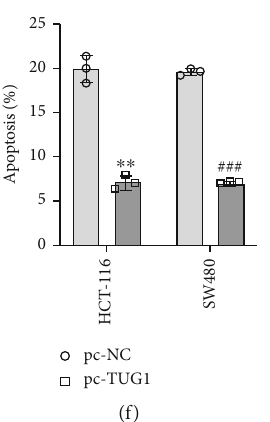
Figure 2: E ff ect of lncRNA TUG1 on oxaliplatin resistance of CRC stem cells. (a) lncRNA TUG1 was silenced in the CD133 + /CD44 + cells isolated from HCT-116 and SW480 cells, and then, the cells were treated with 0, 1, 2, 4, 8, and 16 μ M oxaliplatin for 48 h. Cell Counting Kit- 8 (CCK-8) assay was performed to assess the viability of CD133 + /CD44 + isolated from HCT-116 and SW480 cells. (b) lncRNA TUG1 was silenced in the CD133 + /CD44 + cells isolated from HCT-116 and SW480 cells, and then, the cells were treated with 4 μ M oxaliplatin for 48 h. The apoptosis of CD133 + /CD44 + isolated from HCT-116 and SW480 cells was detected using fl ow cytometry. (c) The quantitative results of cell apoptosis. (d) lncRNA TUG1 was overexpressed in the CD133 + /CD44 + cells isolated from HCT-116 and SW480 cells, and then, the cells were treated with 0, 1, 2, 4, 8, and 16 μ M oxaliplatin for 48 h. Analysis of the viability of CD133 + /CD44 + isolated from HCT-116 and SW480 cells by CCK-8 assay. (e) lncRNA TUG1 was overexpressed in the CD133 + /CD44 + cells isolated from HCT-116 and SW480 cells, and then, the cells were treated with 4 μ M oxaliplatin for 48h. Detection of the apoptosis of CD133 + /CD44 + isolated from HCT-116 and SW480 cells using fl ow cytometry. (f) The quantitative analysis of cell apoptosis. ∗ P < 0 : 05 , ∗∗ P < 0 : 01 , and ∗∗∗ P < 0 : 001 vs. si-NC or